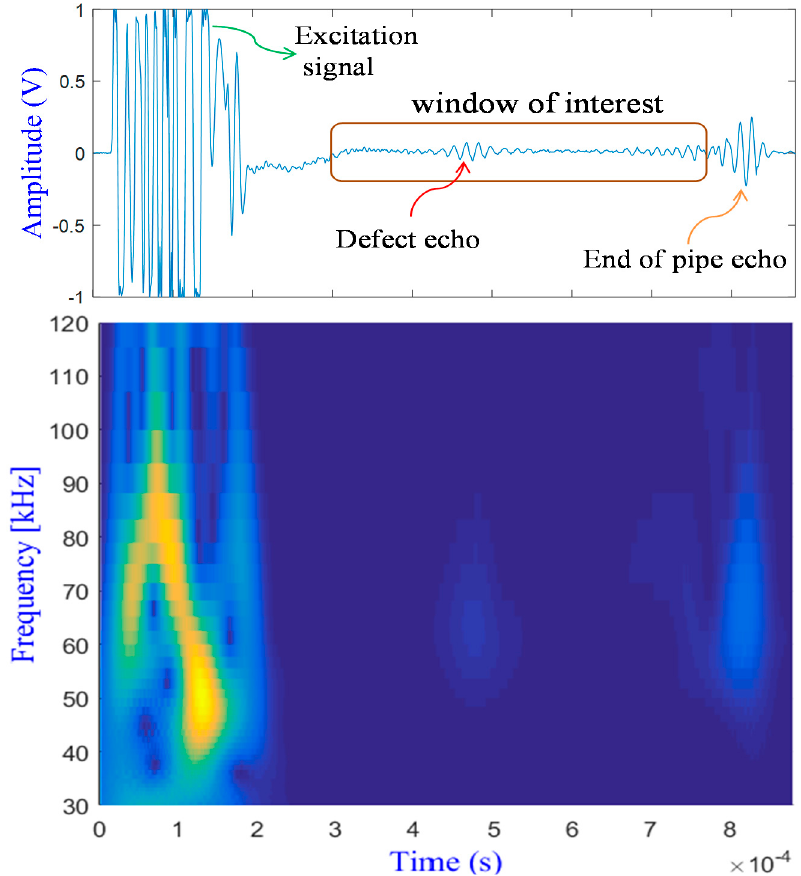
Figure 8. Example of a measured signal from a damaged pipe (top) and its time-frequency representation (bottom).